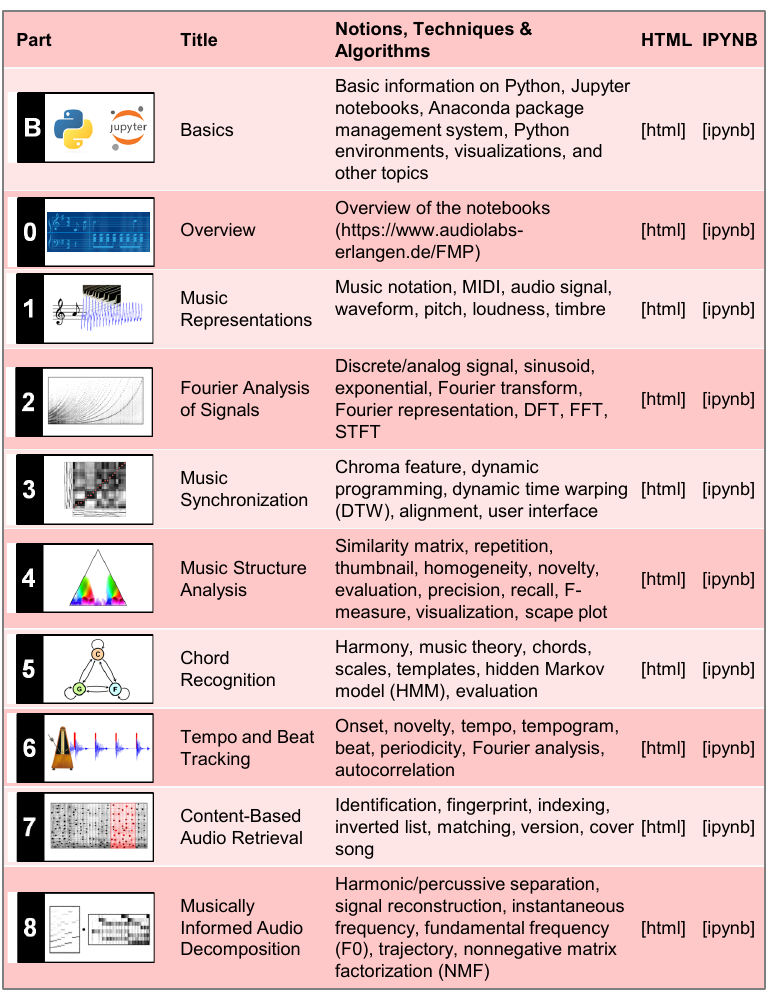
Figure 2. Content of FMP notebooks structured along with the eight chapters of the textbook